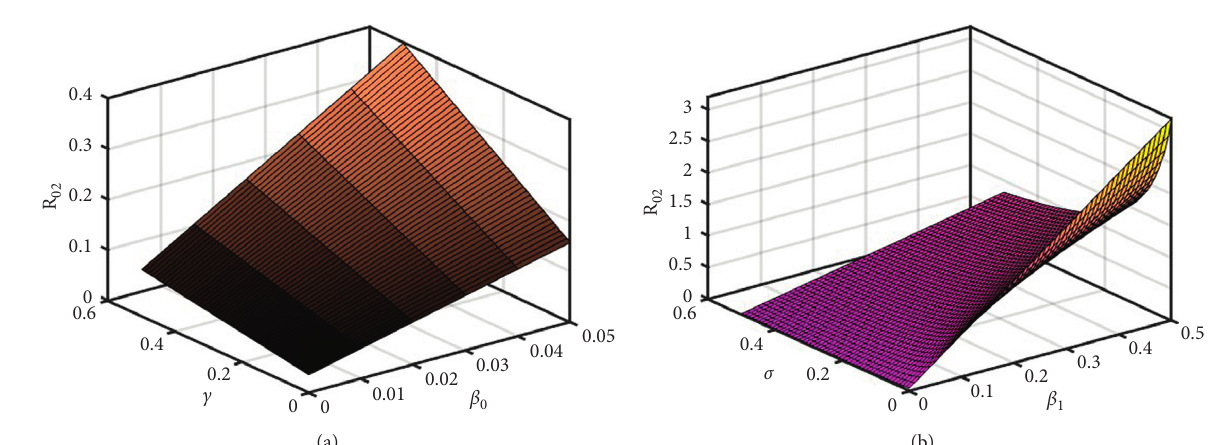
Figure 2: The phase space of (a) R